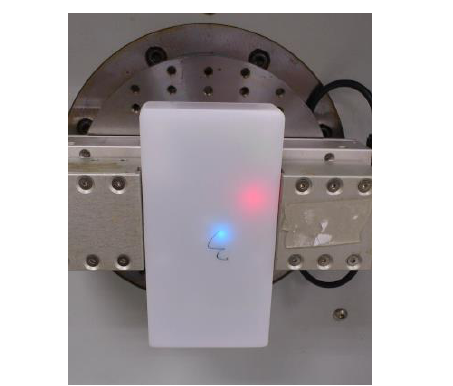
Figure 5. Single-axis Rotation Platform